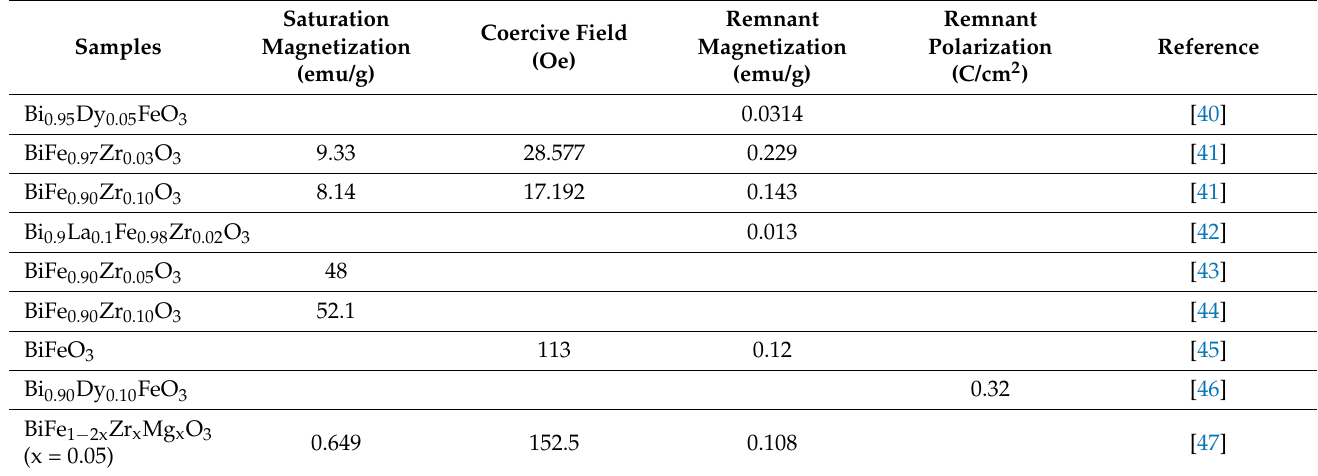
Figure 7. Canted antiferromagnetism spin configuration causes net magnetization in doped bismuth ferrite thin film by the Dzyaloshinskii–Moriya interaction. Table 3. The ferromagnetic and ferroelectric values of previous